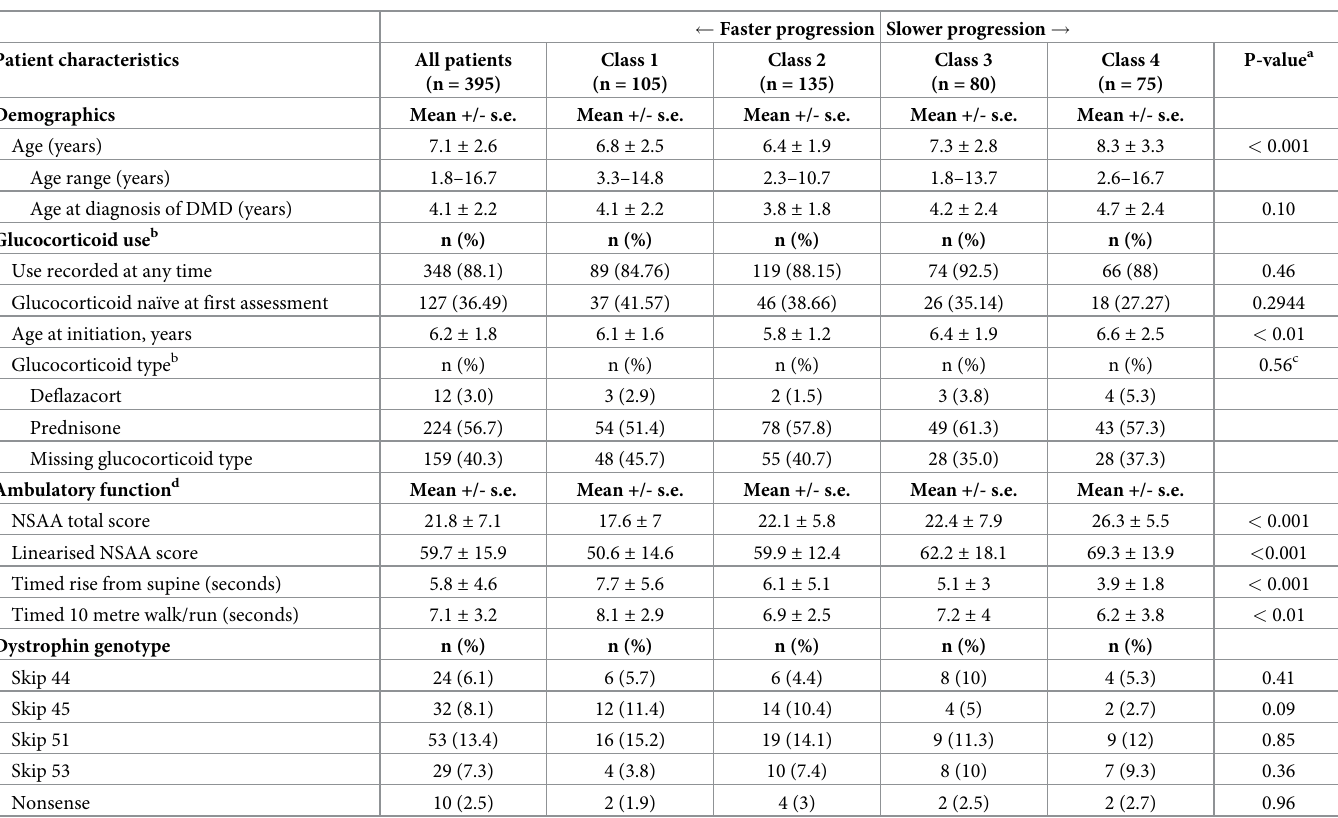
Table 1. Patient characteristics at first NSAA